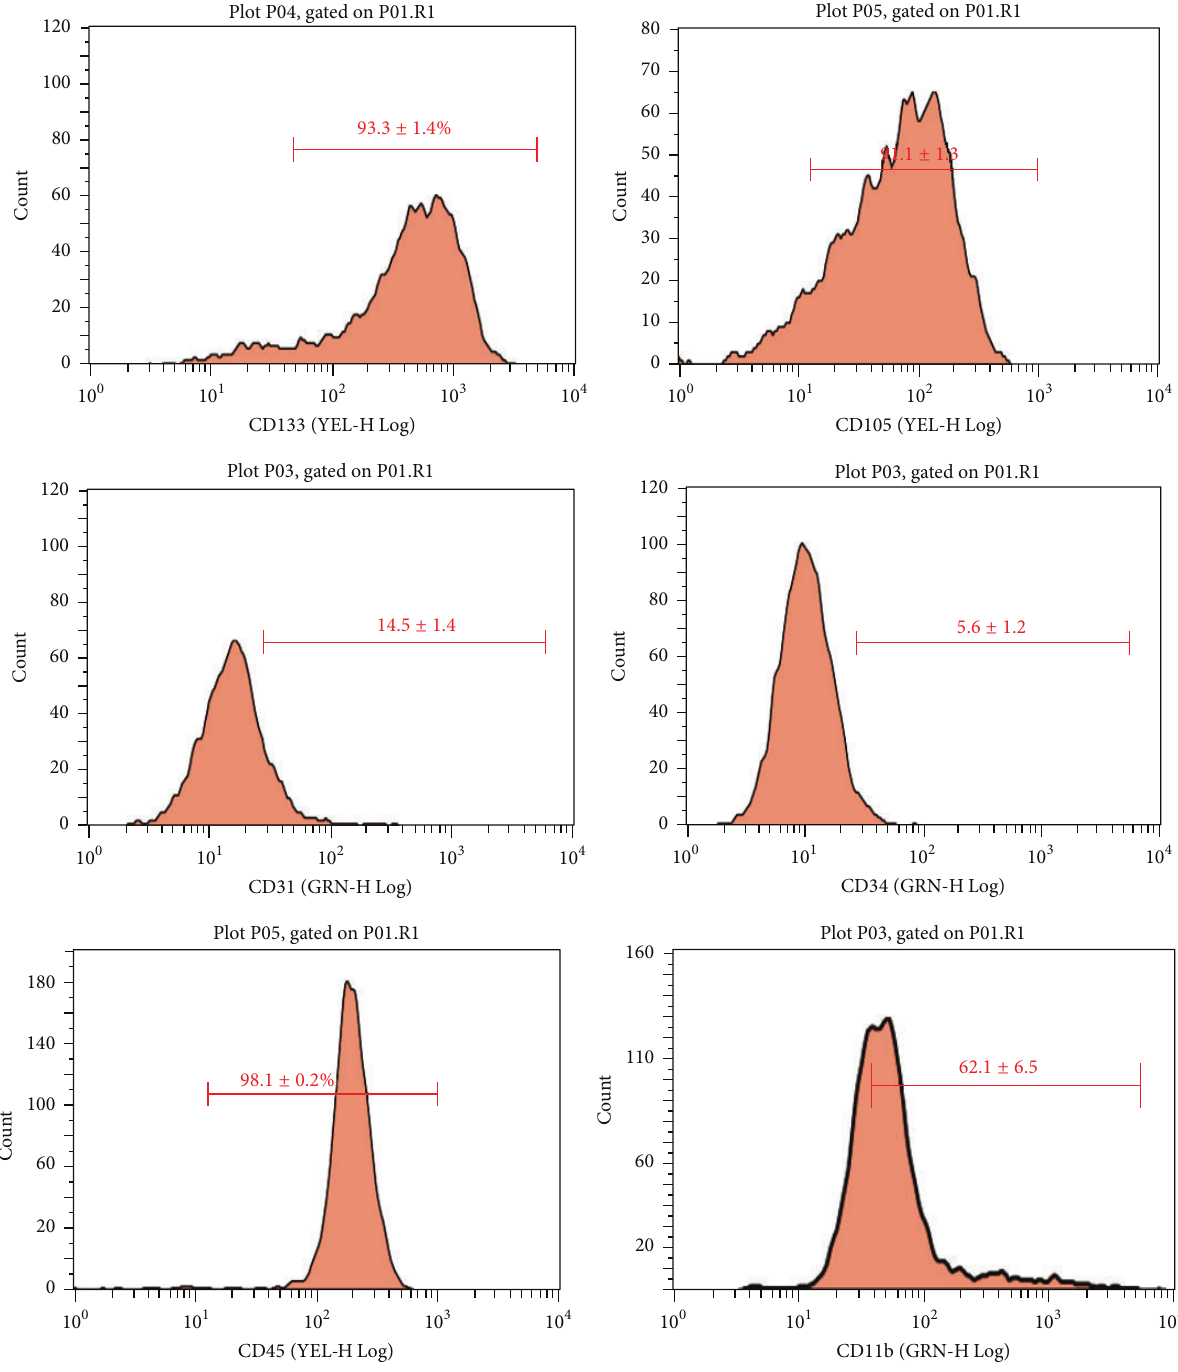
Figure 2: The expression of cell surface markers in EPCs. Adherent cells were positive for CD133 ( 93.3 ± 1.4 %), CD105 ( 91.1 ± 1.3 ), CD31 ( 14.5 ± 1.4 ), CD34 ( 5.6 ± 1.2 ), CD45 ( 98.1 ± 0.2 %), and CD11b ( 62.1 ± 6.5 ). All assays were triplicated and demonstrated similar